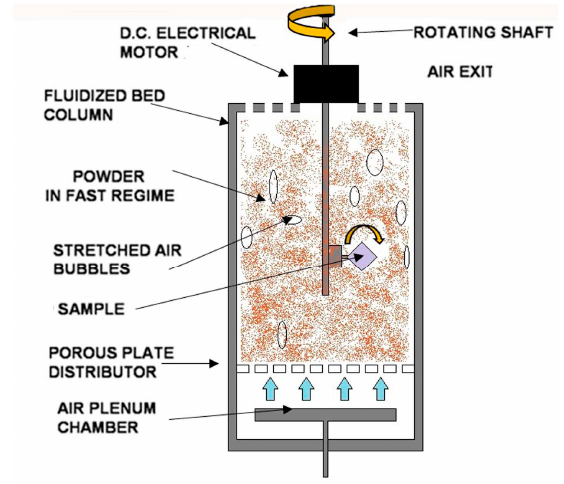
Figure 1. Representation of the fluidized bed (FB) device.